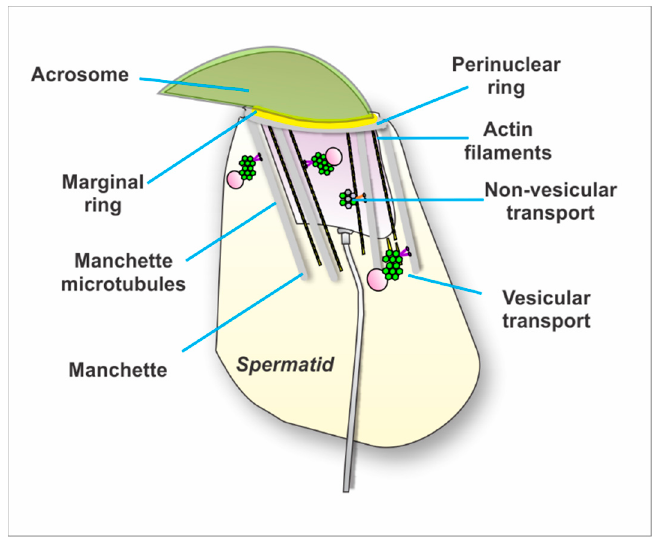
Figure 3. Model illustrating the intramanchette transport mechanism. Illustration represents a mouse spermatid. The manchette is a transitory organelle surrounding the elongating spermatid nucleus. It consists of bundles of microtubules connected to a perinuclear ring and filaments of actin intercalated between the microtubules. Proteins are transported on these tracks to specific intracellular sites during the process of sperm differentiation. Some proteins form large complexes that can transport vesicular as well as non-vesicular cargos.